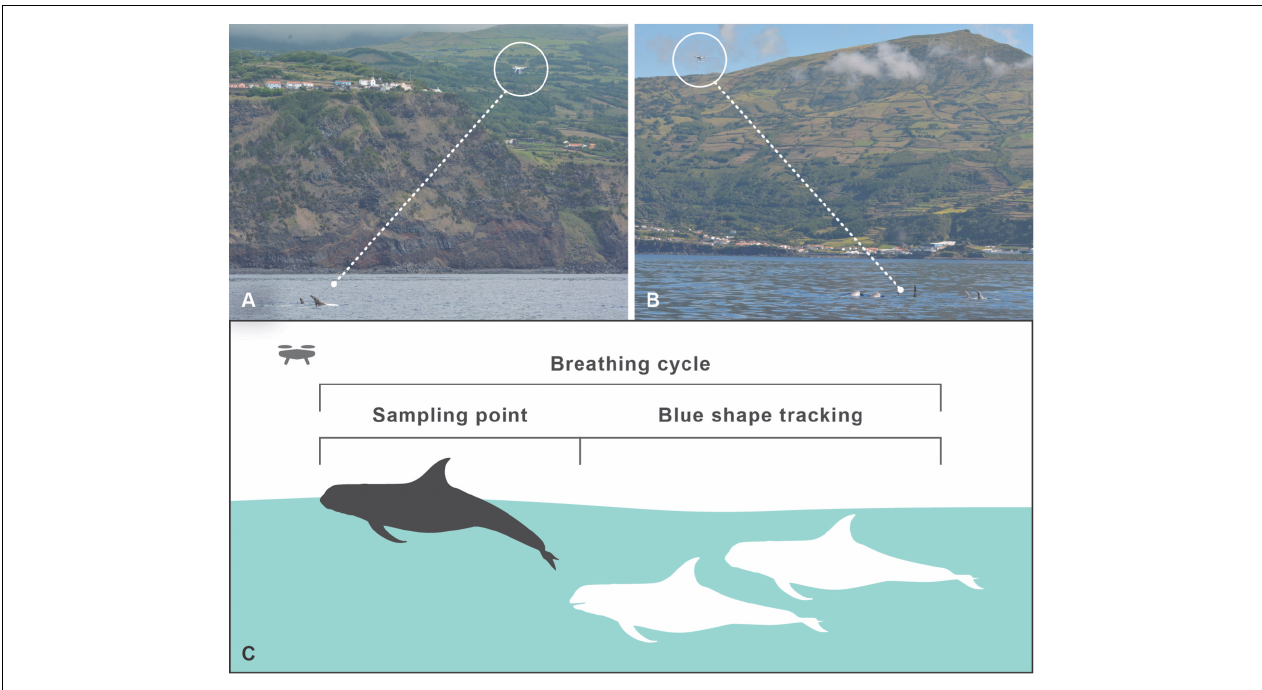
FIGURE 1 | Drone operating protocol. (A,B) Positions of the UAV, capturing all group members. (C) UAV data sampling during surfacing. Due to the light skin coloration of adult Risso’s dolphins, individuals show up as a blue shape when diving deeper (up to a few meters depth, depending on light and water conditions), and can continue to be tracked for continuous focal group follows, especially during resting/traveling